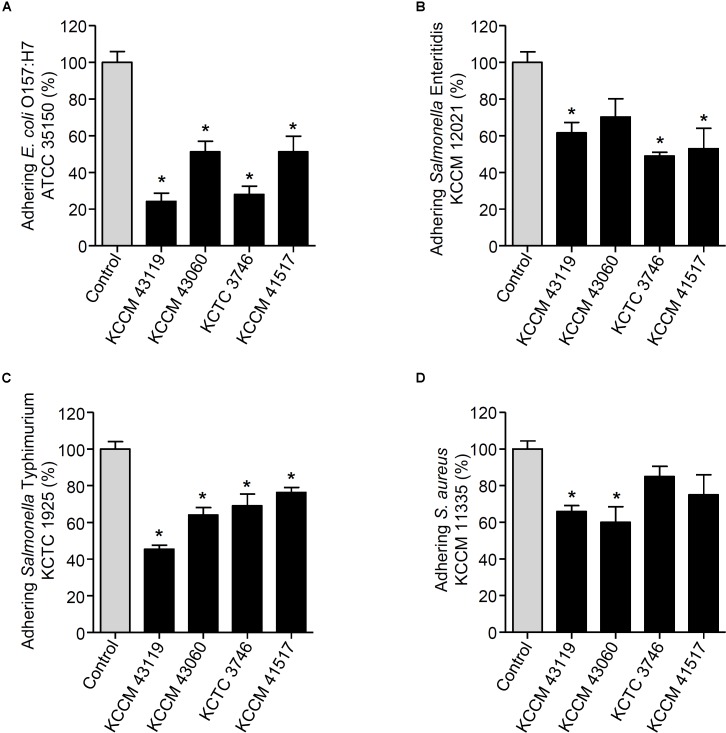
Changes in adhesion of E. coli O157:H7 ATCC 35150 (A), Salmonella Enteritidis KCCM 12021 (B), Salmonella Typhimurium KCTC 1925 (C), or S. aureus KCCM 11335 (D) to HT-29 cells. HT-29 cells were co-treated with foodborne pathogenic bacteria and the LAB strains (L. curvatus KCCM 43119, Ln. mesenteroides KCCM 43060, W. cibaria KCTC 3746, or W. koreensis KCCM 41517) for 1 h and the adhesion of foodborne pathogenic bacteria was determined. The adhesion of foodborne pathogenic bacteria alone to HT-29 cells was assigned to 100% (control). An asterisk (∗) indicates the statistical significance compared with control (P < 0.05).